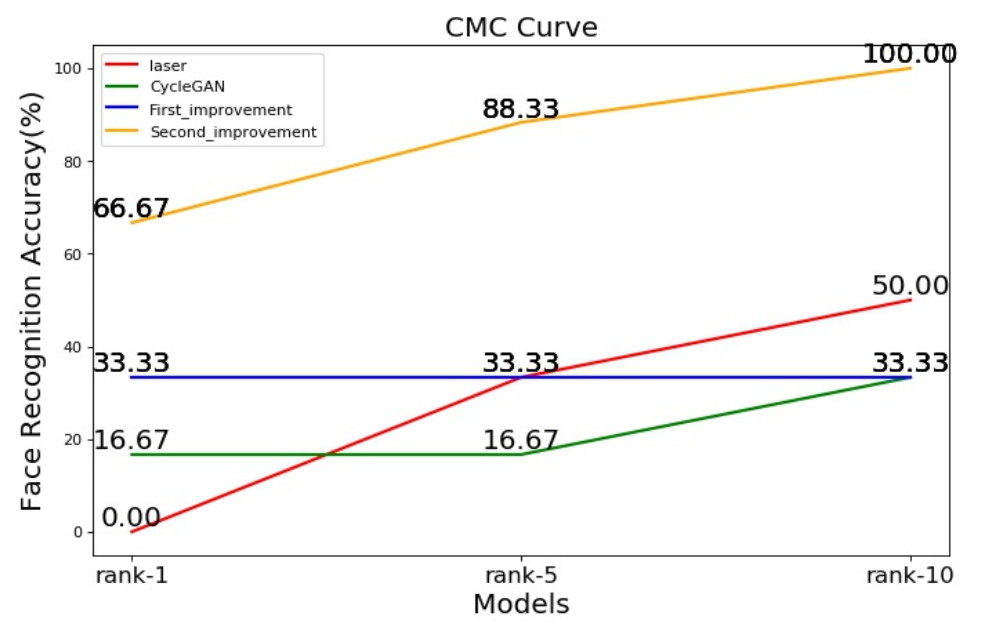
Figure 15. CMC curve of face recognition accuracy.